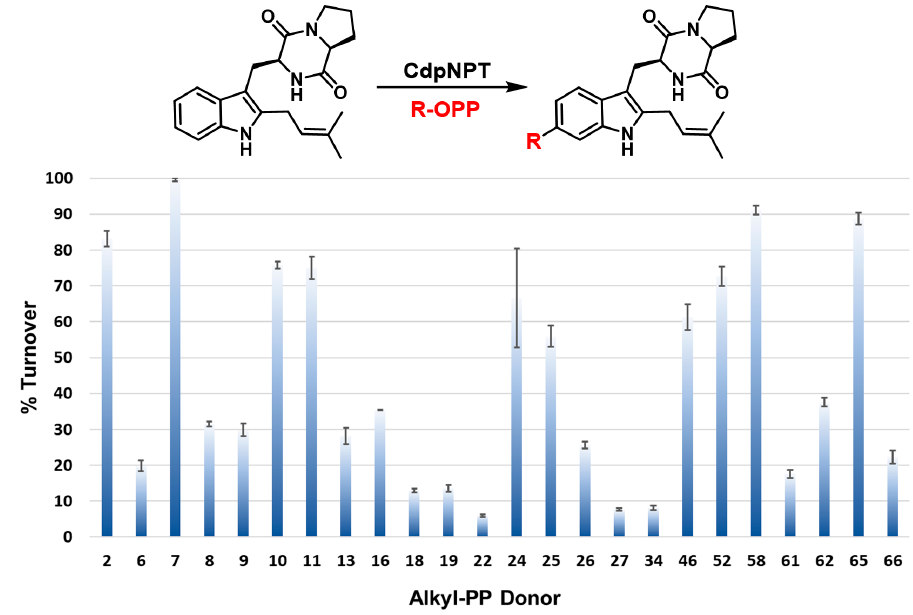
Figure 3. Alkyl donor profile of analytical ‐ scale CdpNPT ‐ catalyzed reactions with TPS ‐ B. The average percent conversion of all positive reactions is shown with the associated standard deviations (n = 2) as determined by RP ‐ HPLC at 280 nm (see Supporting Information, Figure S1). Each reaction was carried out in a 20 μ L volume and contained 1.5 mM alkyl ‐ PP, 1 mM TPS ‐ B, and 10 μ M purified CdpNPT in a reaction buffer (25 mM Tris pH 7.8, and 5 mM CaCl 2 ) incubated at 35 °C for 18 h. No product formation was observed in the absence of CdpNPT or alkyl ‐ PP.